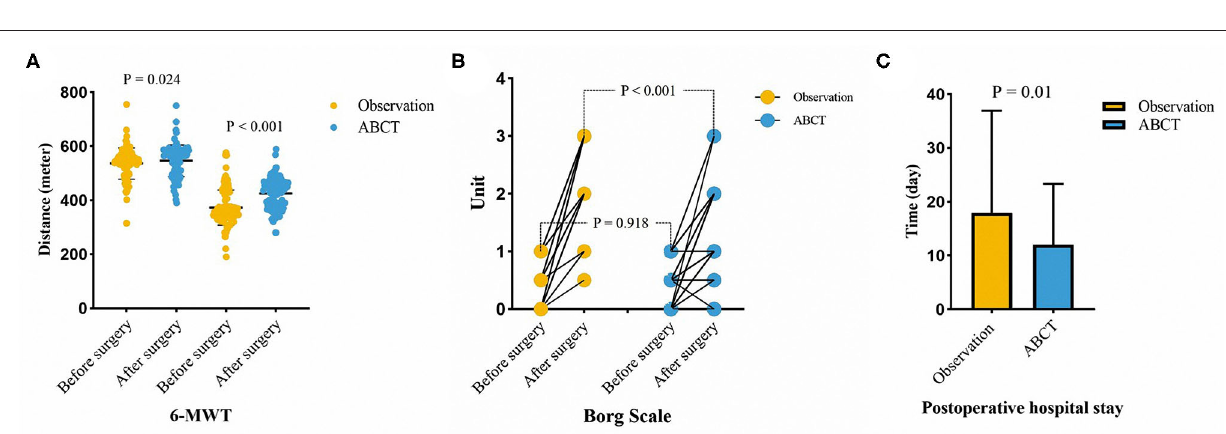
FIGURE 5 | The results of 6-MWT (A) , Borg scale (B) , and the time of postoperative hospital stay (C) in two